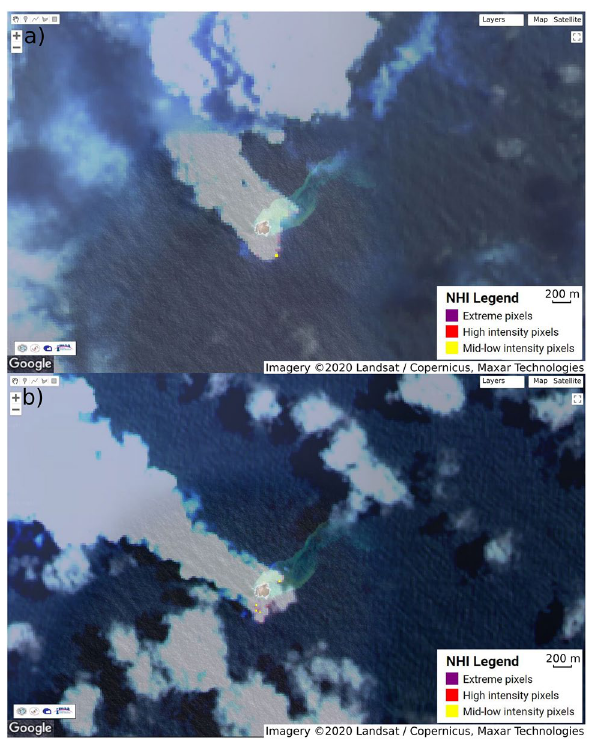
are shown in transparent grey color. Background: Google Earth satellite image showing old Late’iki Island prior to the mid-October 2019 eruption. Imagery Landsat/Copernicus (2020), Maxar